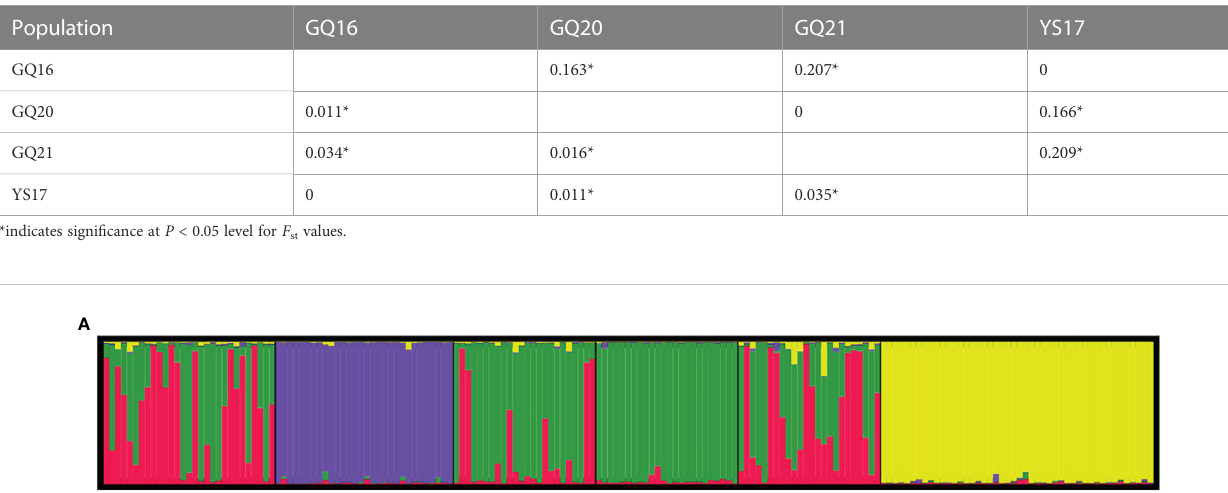
TABLE 6 Pairwise F st values between four native populations of Undaria pinnati fi da from China estimated using the combined sequences of cox3 gene and tatC - tLeu region (above diagonal) and microsatellites (below diagonal). Population